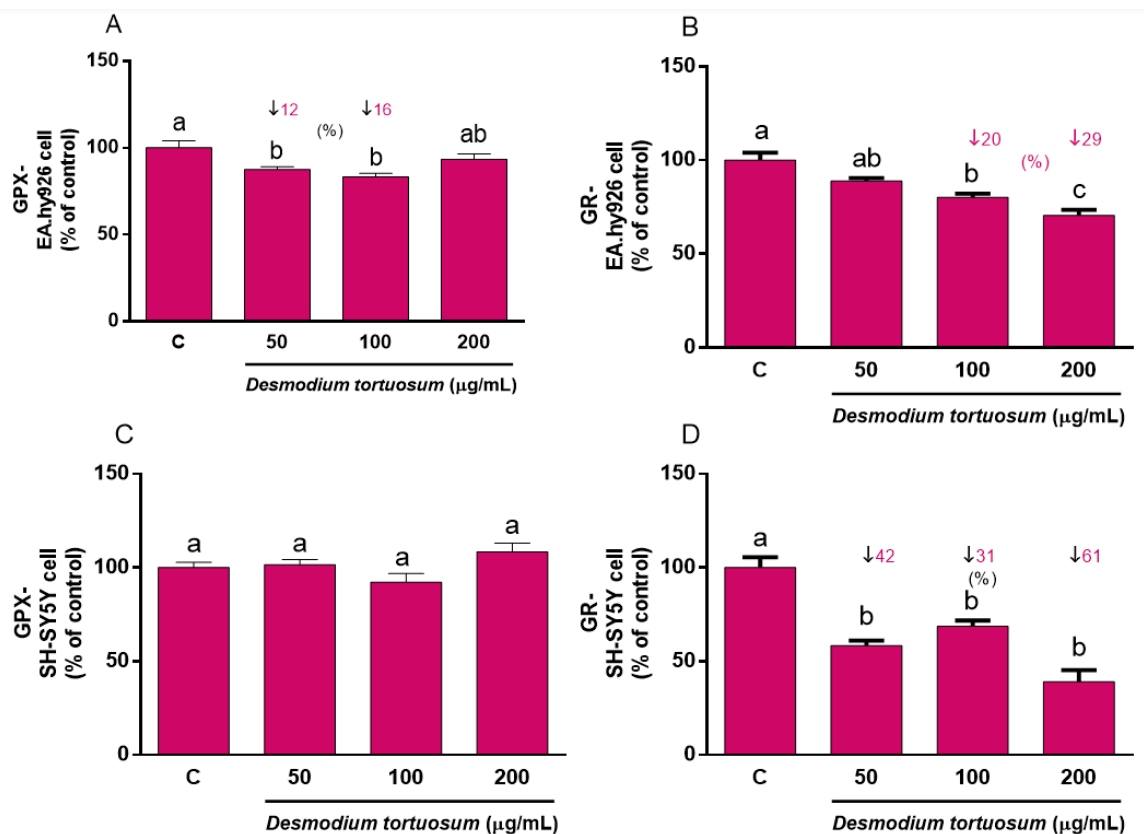
Figure 2. Antioxidant effects by D. tortuosum extract on ROS production induced by t-BOOH in EA.hy926 ( A ) and SH-SY5Y ( B ) cells after co-treatment (red bars, █ ) and pre-treatment (blue bars, █ ) periods. ROS production was measured as fluorescence units. Data are presented as mean ± SEM of six independent experiments. a,b,c,d,e,f Different letters show significance between groups at p < 0.05. ↑ represents percentage increase with respect to control, ↓ represents percentage decrease with respect to t-BOOH.